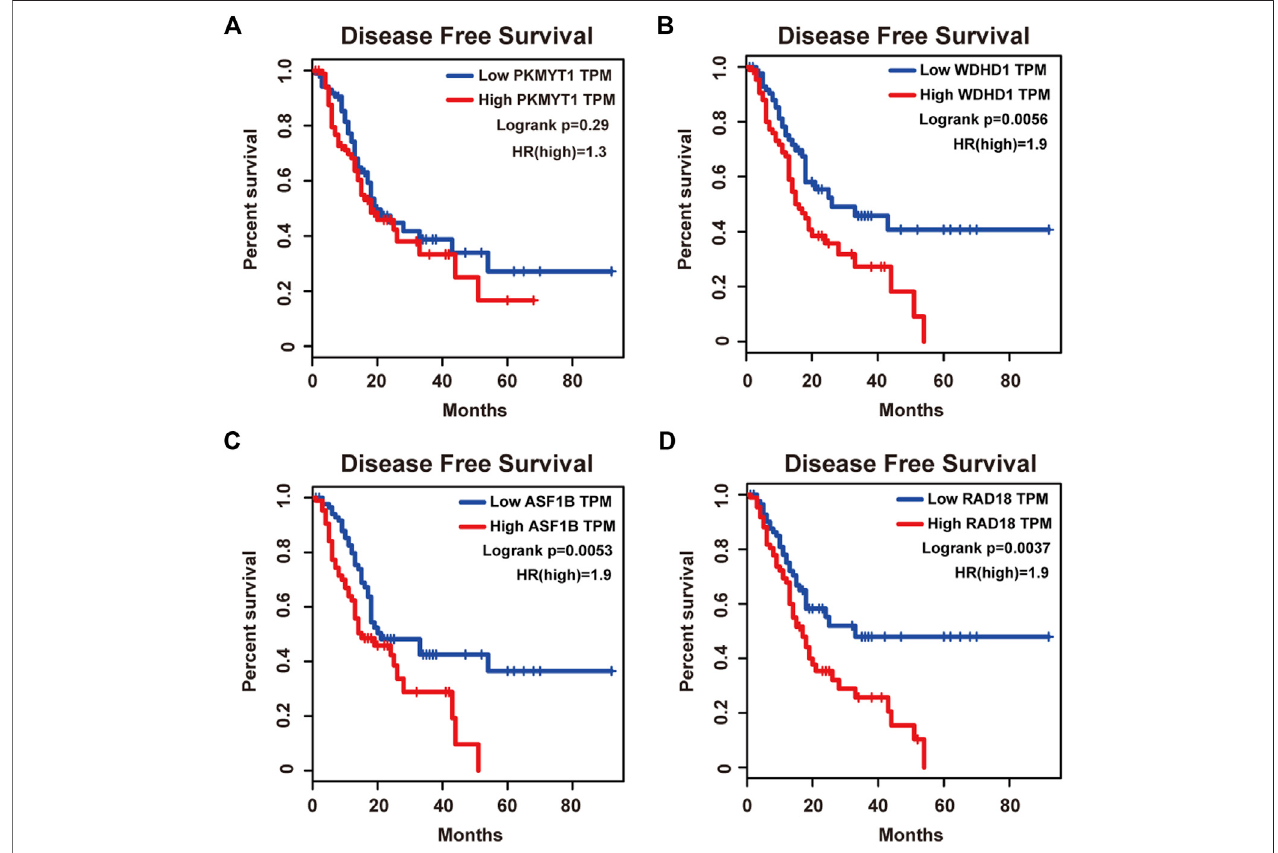
FIGURE 5 | Disease free survival analysis of the four hub genes in pancreatic adenocarcinoma based on the Kaplan-Meier plotter. (A) PKMYT1. (B) WDHD1. (C) ASF1B. (D) RAD18. The high expressions of WDHD1, ASF1B and RAD18 were associated with high risk.